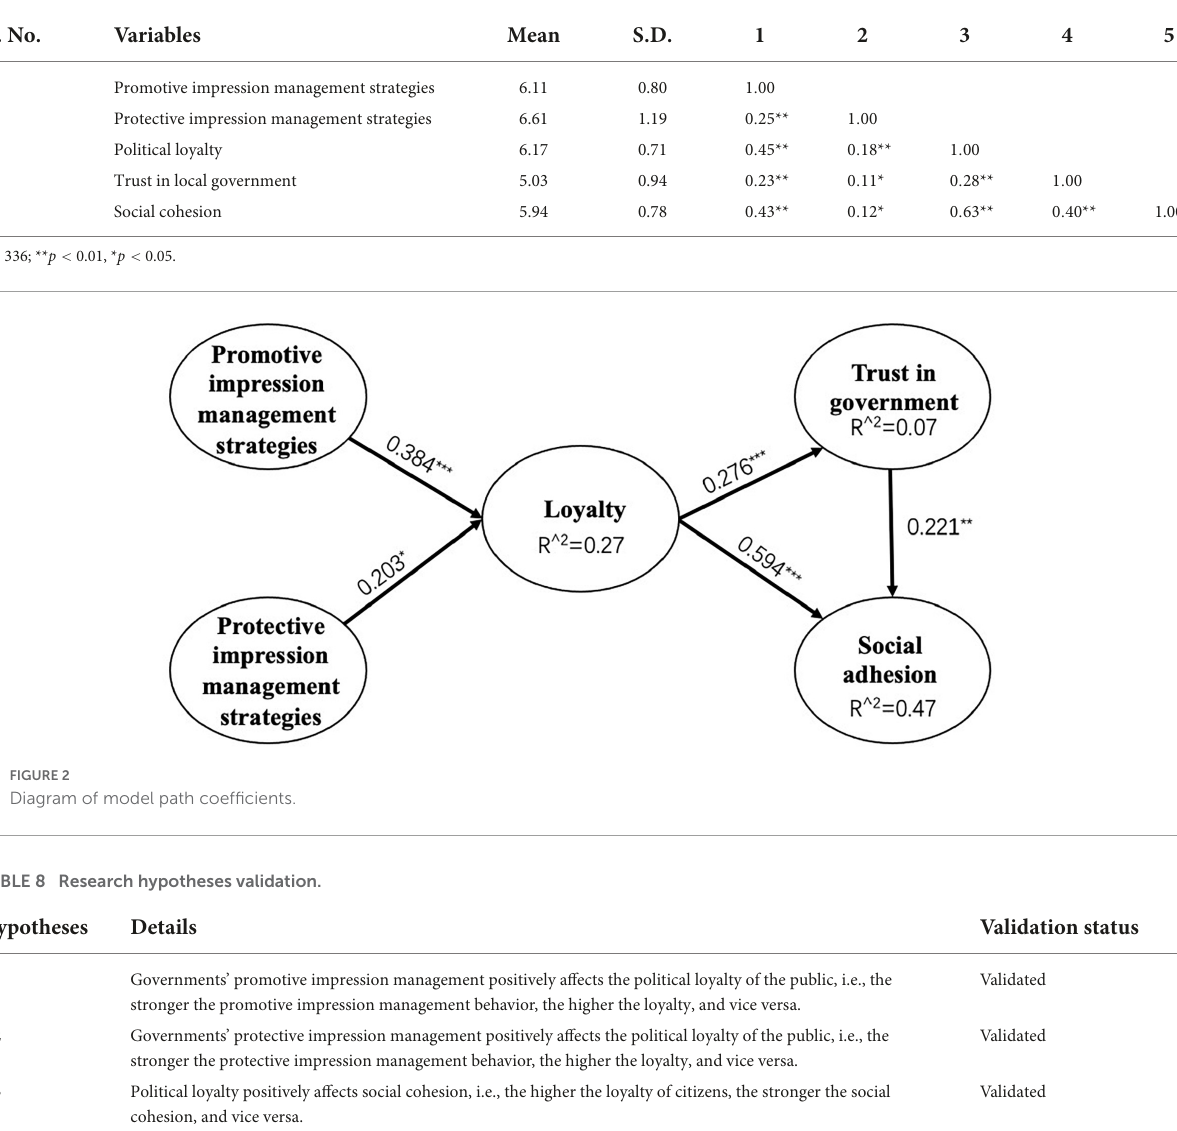
TABLE 7 Means, standard deviations and Pearson correlation coefficients of variables.